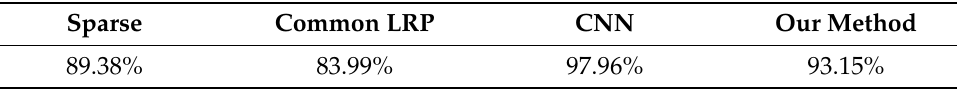
Table 1. Recognition accuracy of positive